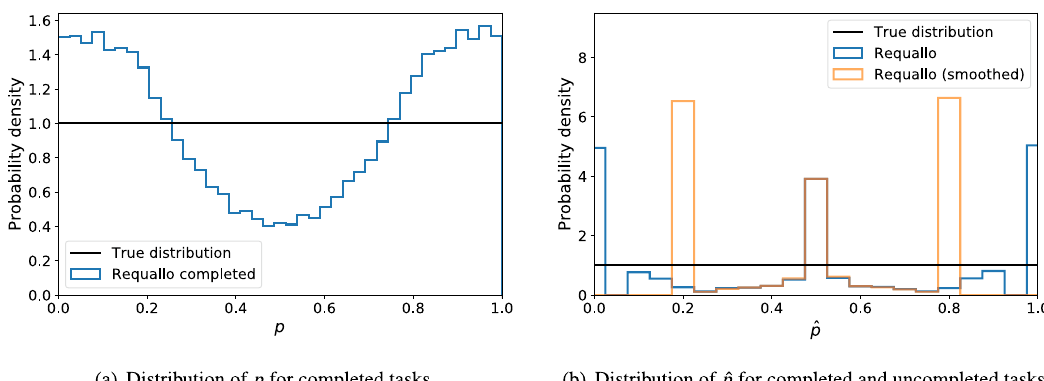
Figure 1. Requallo Allocation leads to non-representative sets of completed tasks, and biased information about problem properties. ( a ) Easy tasks (with p far from 1/2) are over-represented in the set of completed tasks while hard tasks (with p near 1/2) are under-represented. ( b ) Estimates of p are biased, when looking at easy tasks there are pileups at p = ( 0, 1 ) and p = ( 0.2, 0.8 ) for the “smoothed; distribution, looking at hard tasks, there are pileups at p = 0.5